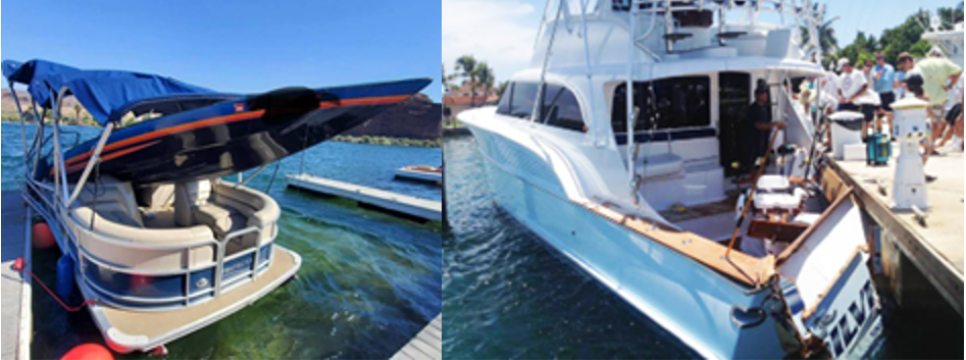
Figure 1. Case in which a small boat crashed during the berthing